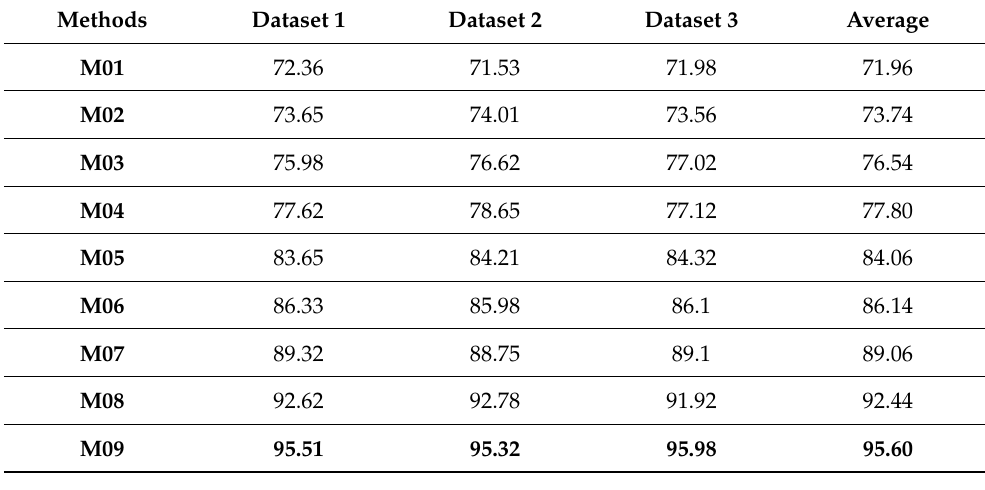
Table 13. Sentiment classification accuracy results using the MLSC.